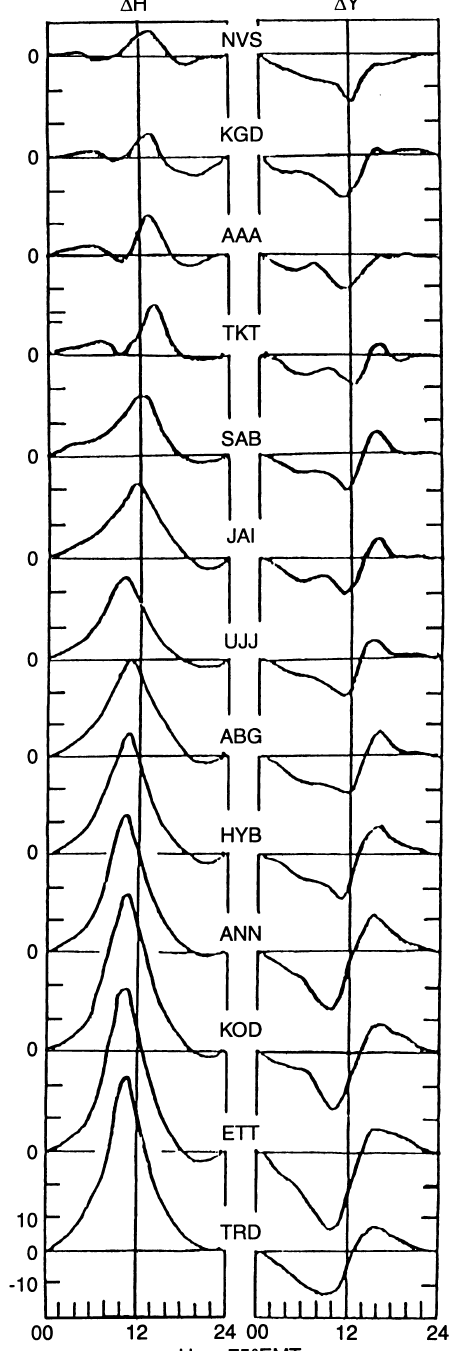
Fig. 2. Daily variations of the horizontal ( D H ) and eastward ( D Y ) fields at each station averaged for the months of January and